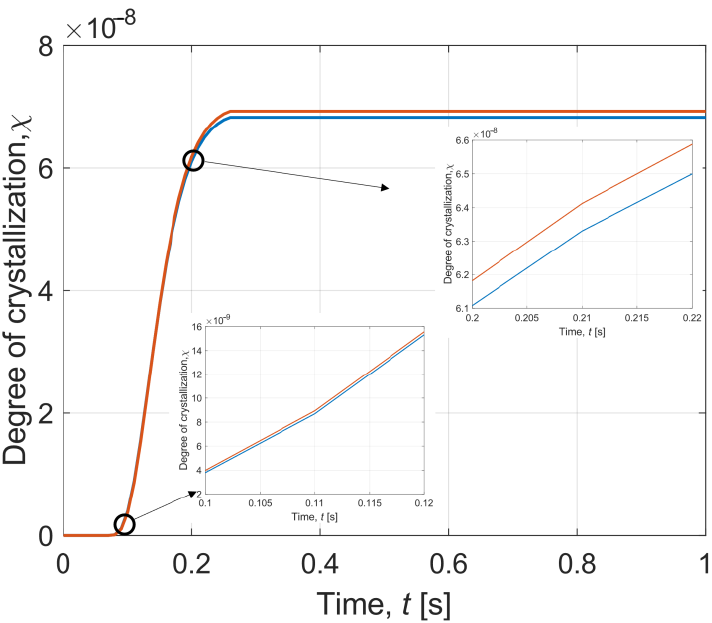
Figure 8. History of interval degree of crystallisation during cooling in time 0 −1 s.